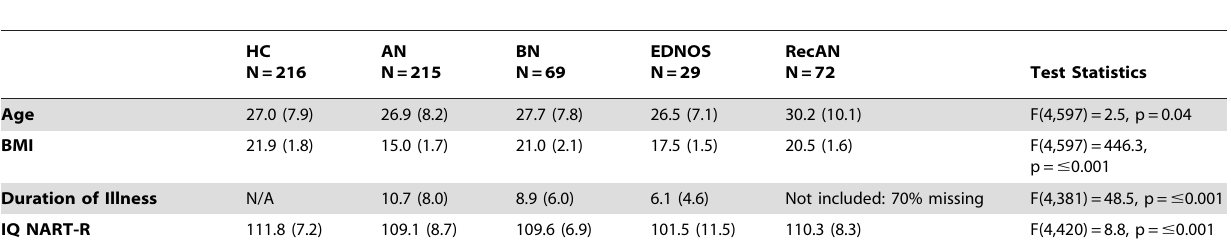
Table 1. Clinical and Demographic Characteristics of the Healthy Control (HC), Eating Disorder (AN, BN and EDNOS) and Recovered AN (REC AN) Groups.